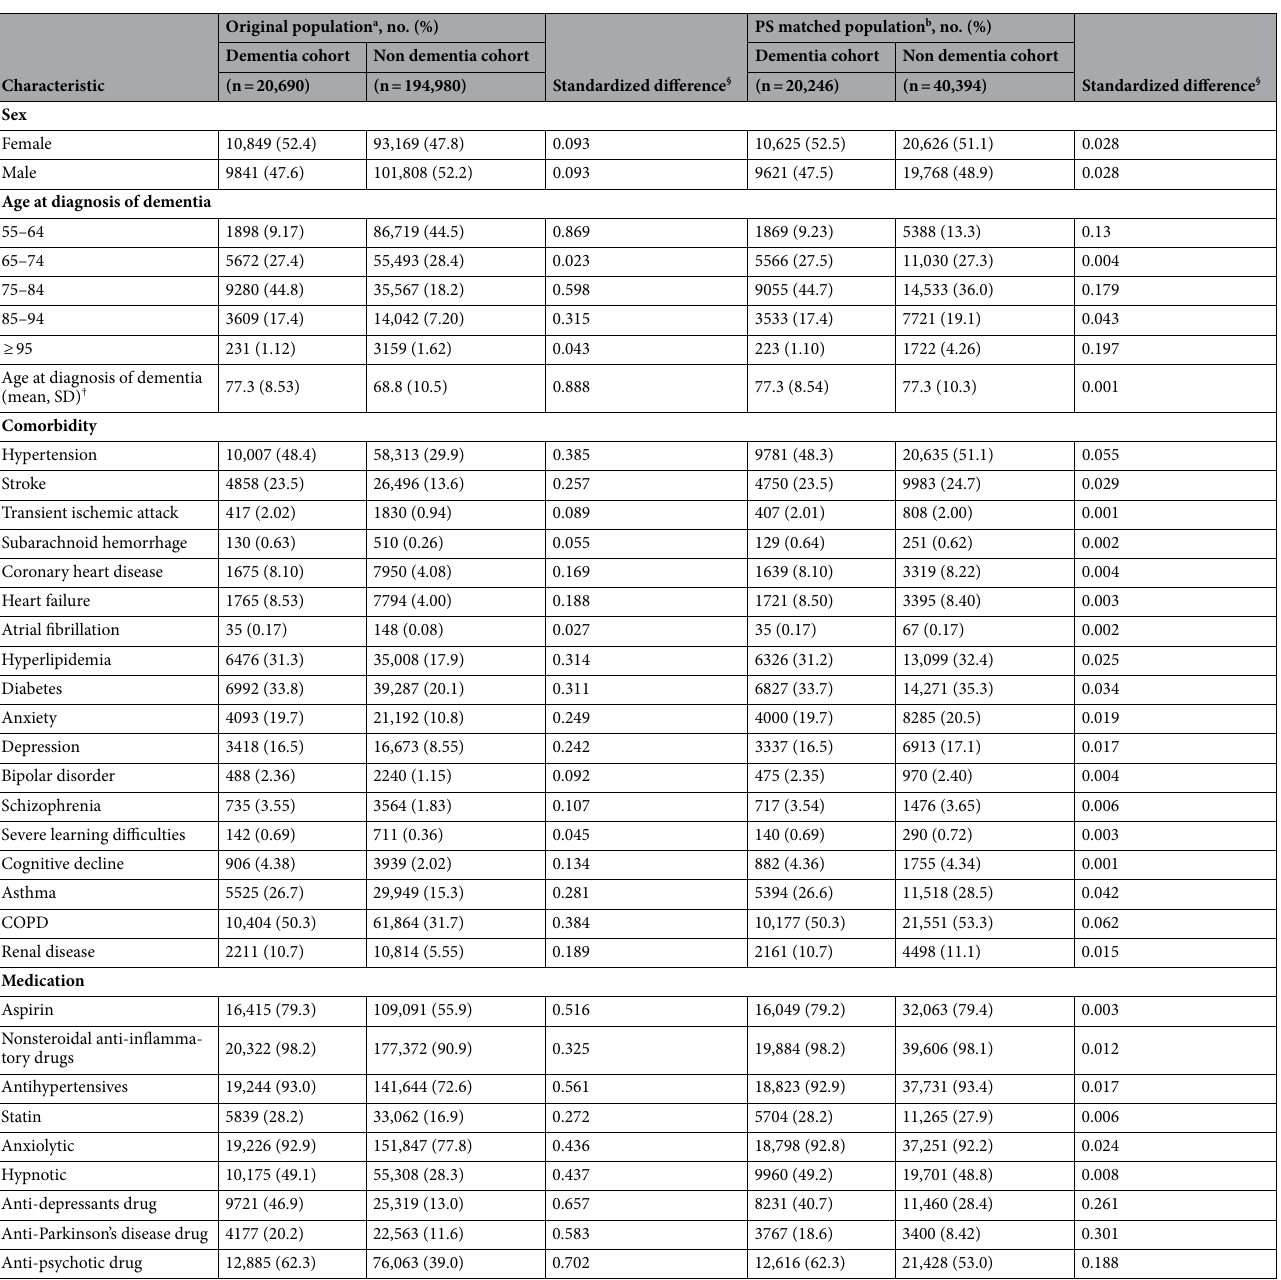
Table 1. Characteristics of patients with and without dementia and comparison between baseline and during follow-up. PS propensity score, COPD chronic obstructive pulmonary disease. a All comorbidities and medications before ps matching. b All comorbidities and medication were after ps matching. *P-value using chi-square for the comparisons between with and without fetal adverse. † Average age using Wilcoxon rank- sum test for verification. § A standardized mean difference of ≤ 0.10 indicates a negligible difference between the